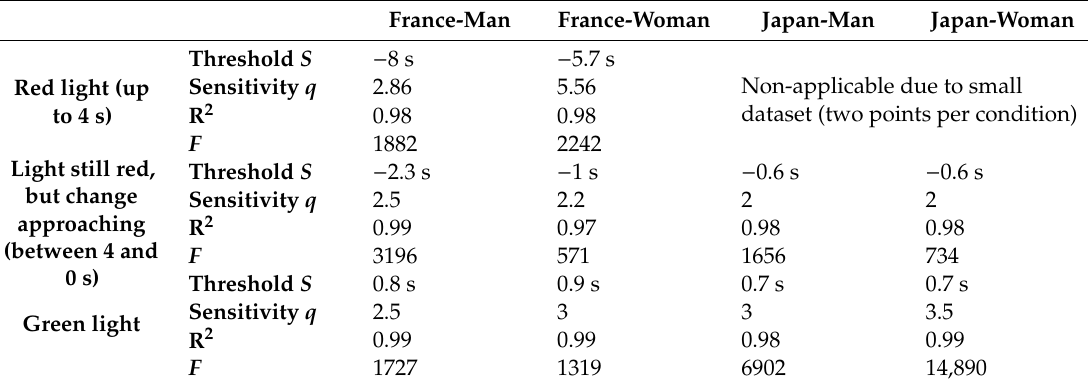
Table 2. Values of threshold S and sensitivity q from the sigmoid curves fitting with the observed data for each category (country-gender) as well as statistical values. All p -values are < 0.00001. France-Man France-Woman Japan-Man Japan-Woman − 5.7 s Non-applicable due to small dataset (two points per